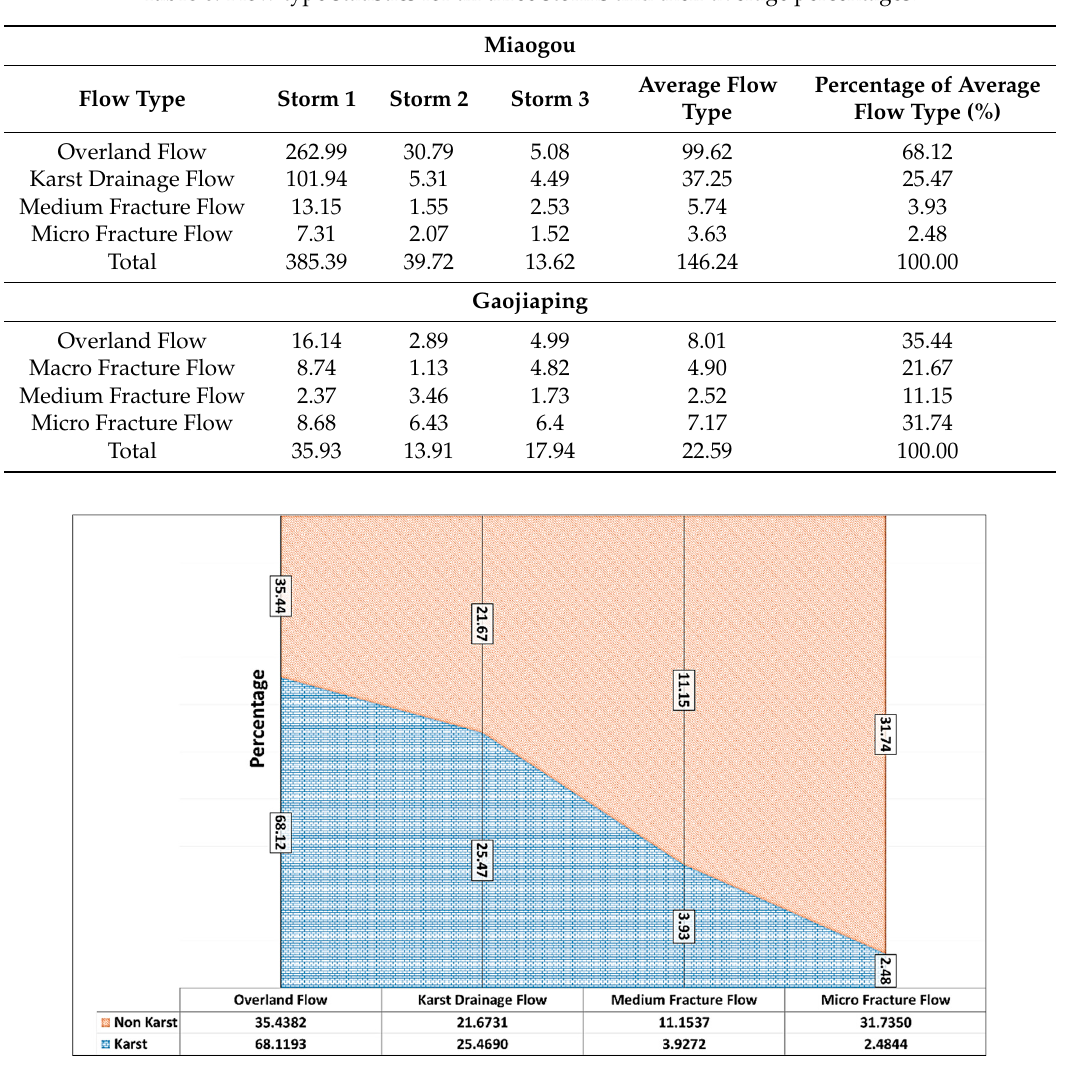
Figure 13. The plot of disparity in flow type average percentages contribution to streamflow.